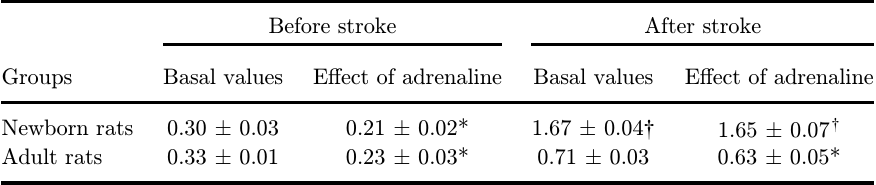
Table 3. The changes in diameter of the sagittal sinus after adrenaline injection before and after stroke in newborn and adult